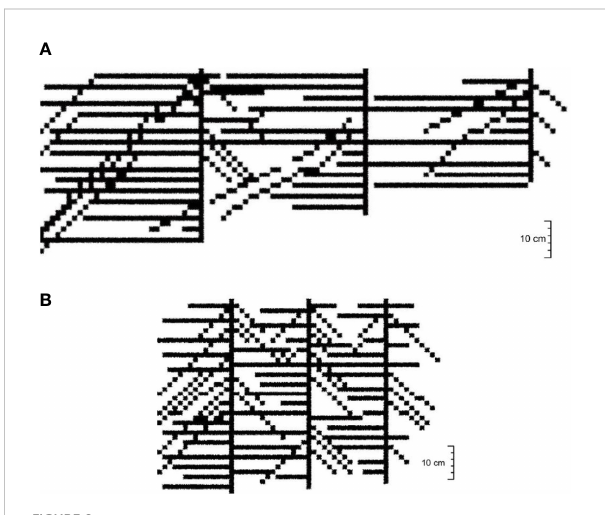
FIGURE 9 Simulation effect diagram of root system architecture of the cotton group. (A) 30-cm Planting spacing. (B) 15-cm planting spacing.